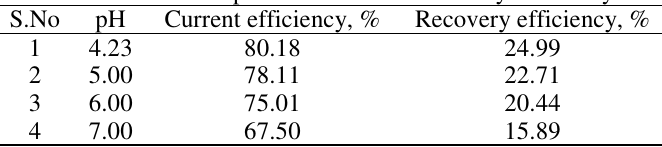
Table 5. Effect of pH on current and recovery efficiency